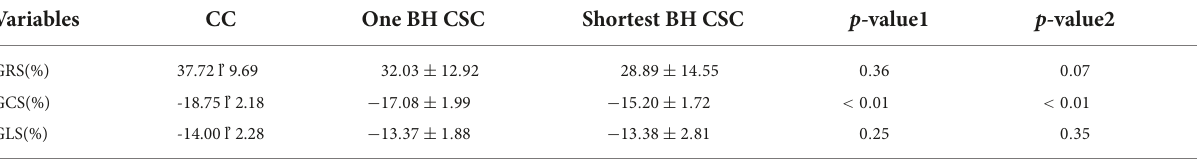
TABLE 2 3D left ventricular global strain assessment between different acquisitions.